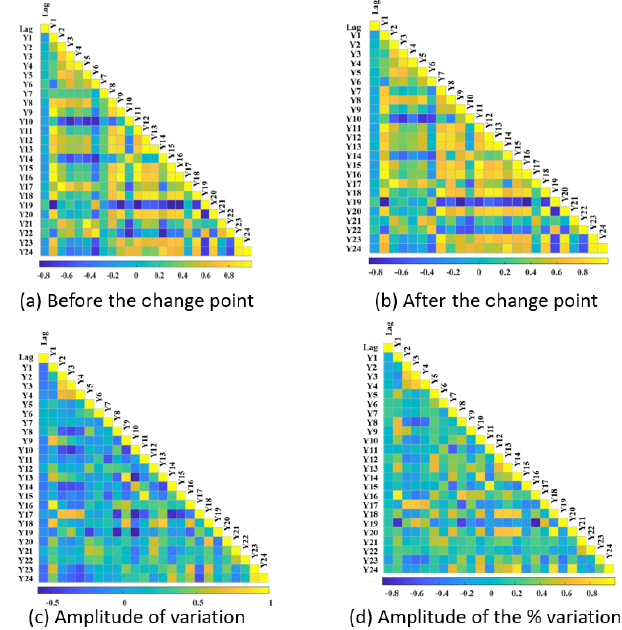
Figure 11. Pearson correlation coefficient based on the association between the length of the time lag of the catchment with multiple climate